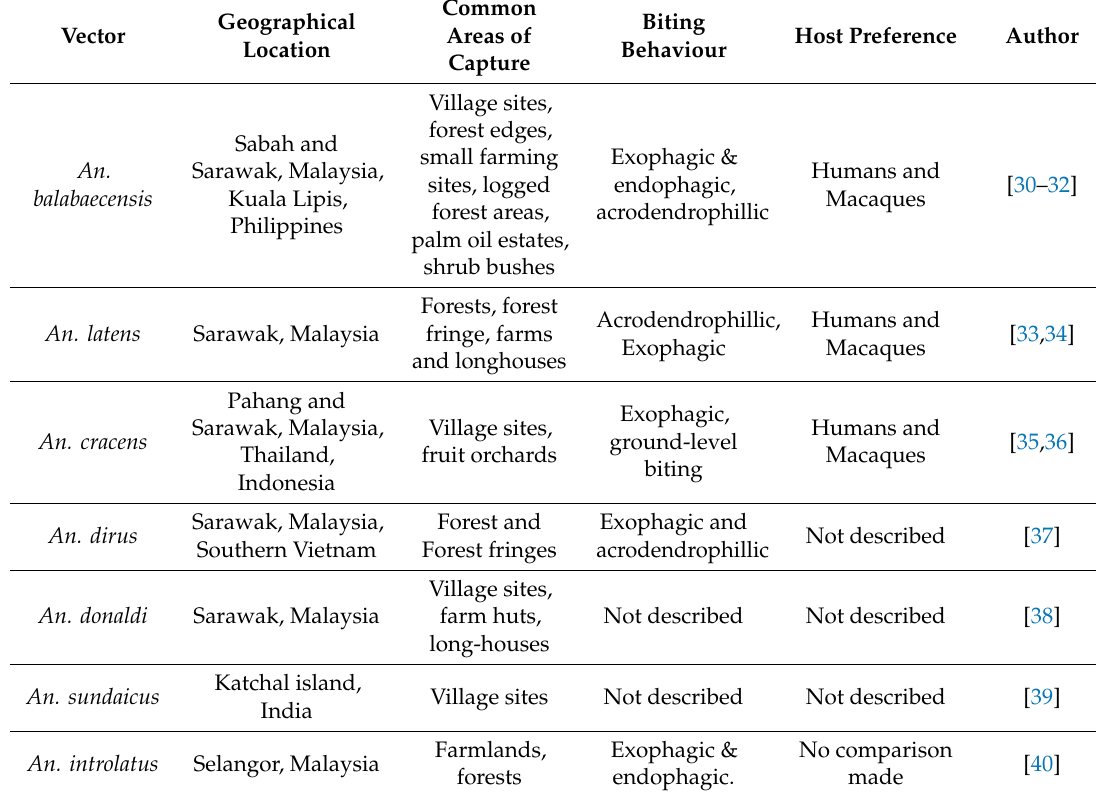
Table 1. The Occurrence of Described Vectors of Plasmodium knowlesi